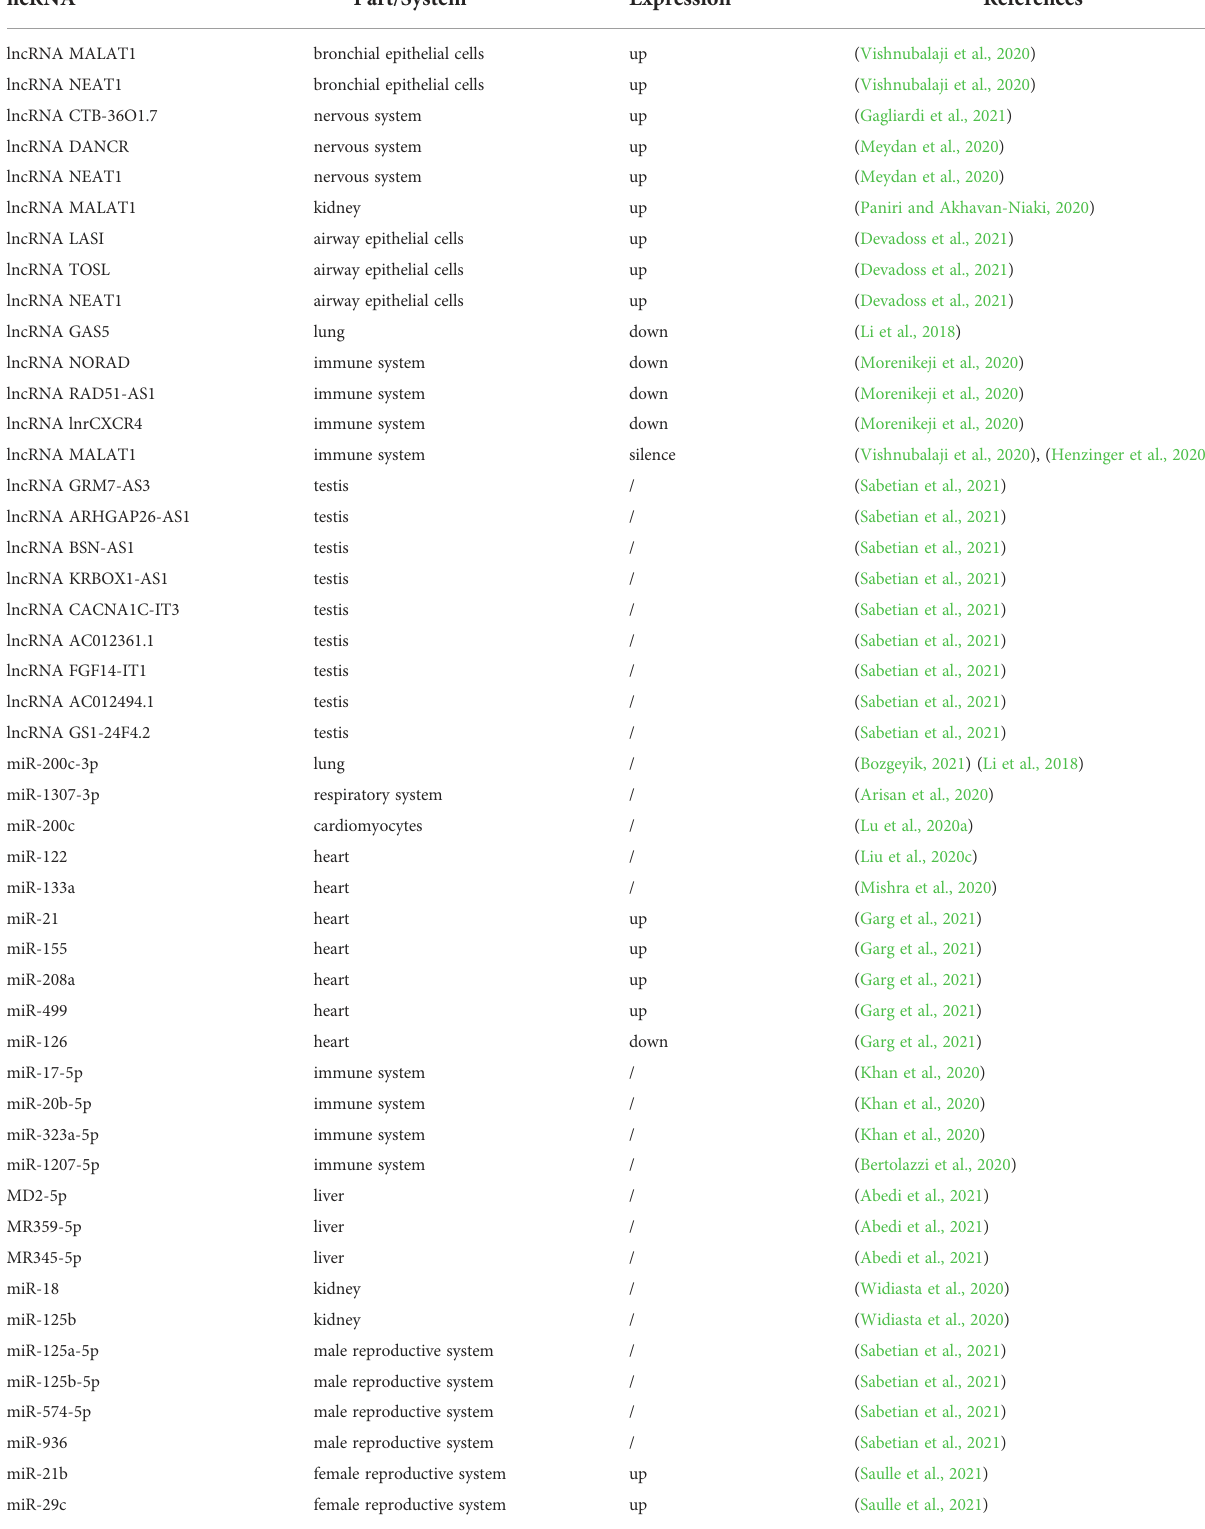
TABLE 1 Relationship between lncRNA, miRNA, circRNA and various systems in COVID-19 patients.